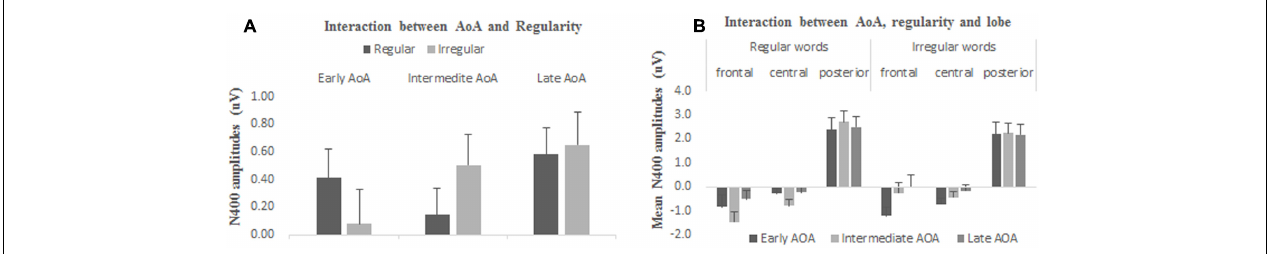
FIGURE 4 | Interaction (A) between AoA and regularity and (B) between AoA, regularity and lobe.